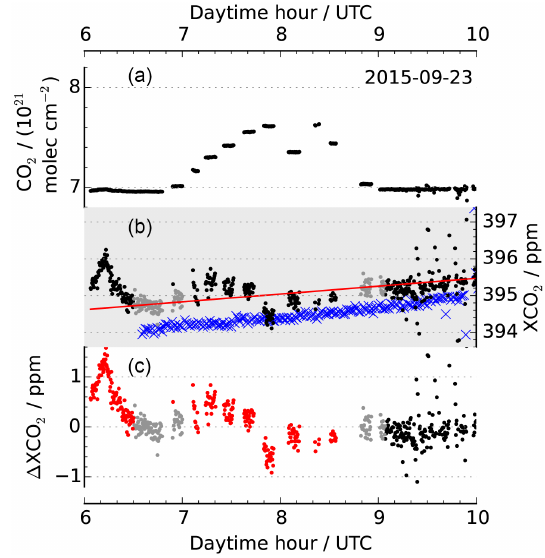
Figure 5. Same as Fig. 4 but for 22 September 2015. Figure 6. Same as Fig. 4 but for 23 September